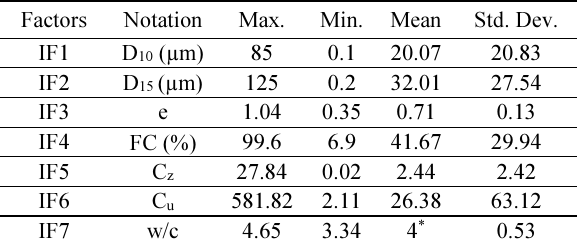
Table 2. Descriptive statistics of historical data